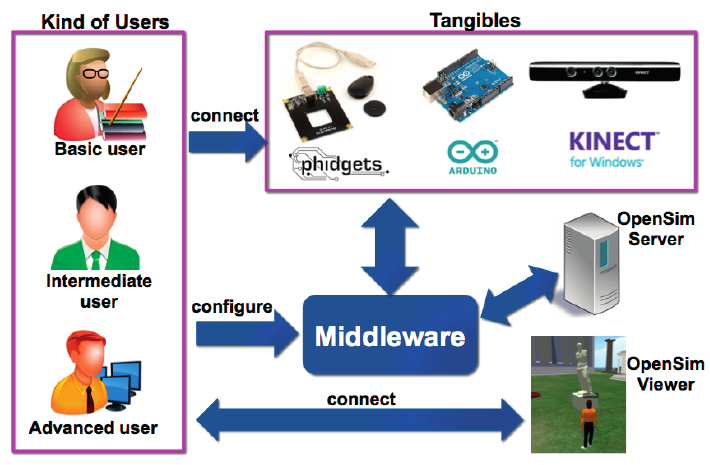
Figure 1. Elements that interact in the